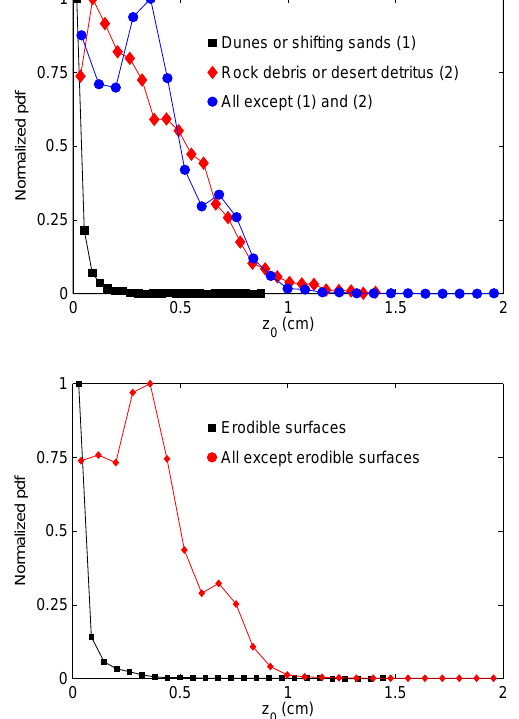
Fig. 7. Top panel: normalized histograms of the PARASOL- ASCAT z 0 estimates for “sand dunes and shifting sands” only, for “rock debris and desert detritus” only, and for the remaining FAO classes (FAO, 2003). Bottom panel: normalized histogram of the PARASOL-ASCAT z 0 estimates for the arid erodible surfaces, as defined by Koven and Fung (2008), as well as for all the remaining